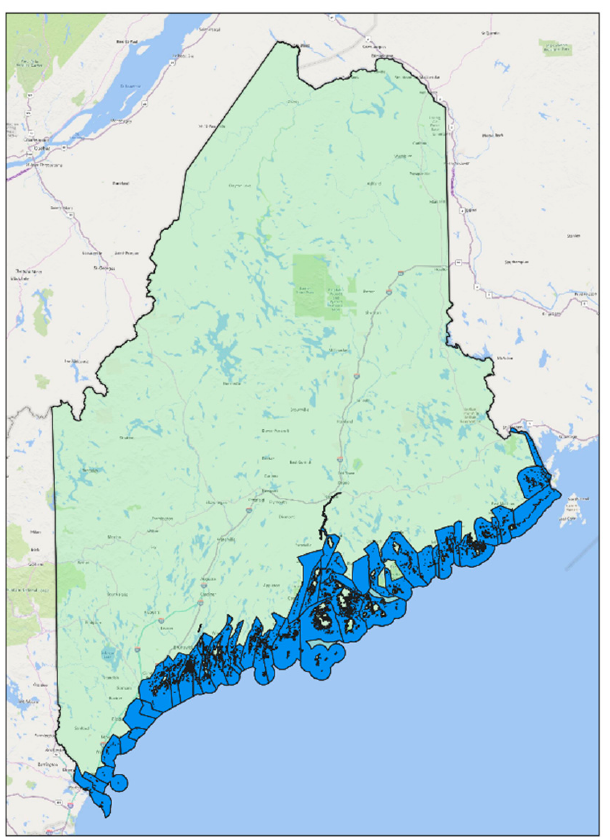
Figure 3. Shellfish Growing Areas as defined by the Maine State Department of Marine Resources. Basemap: Bing maps © 2020 Microsoft.